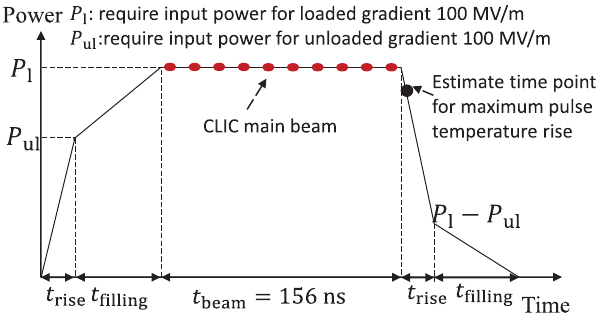
FIG. 4. Pulse surface heating calculation in CLIC accelerating structures.